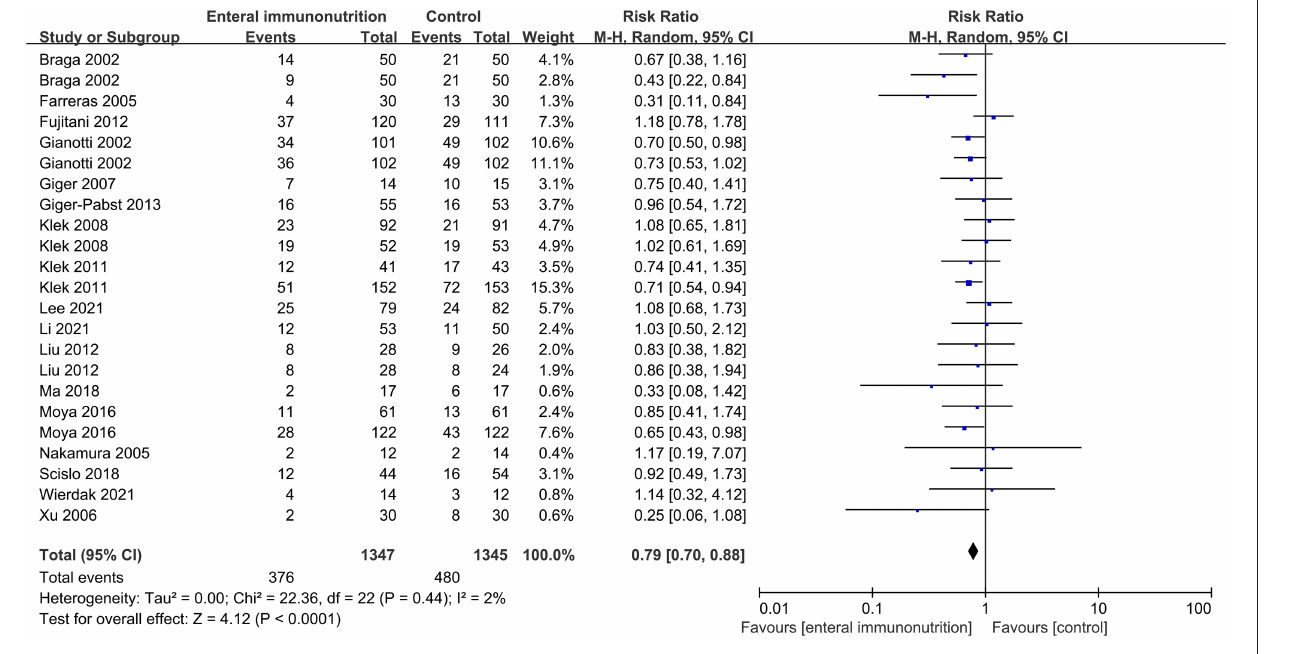
FIGURE 2 | Forest plot of meta-analysis of overall